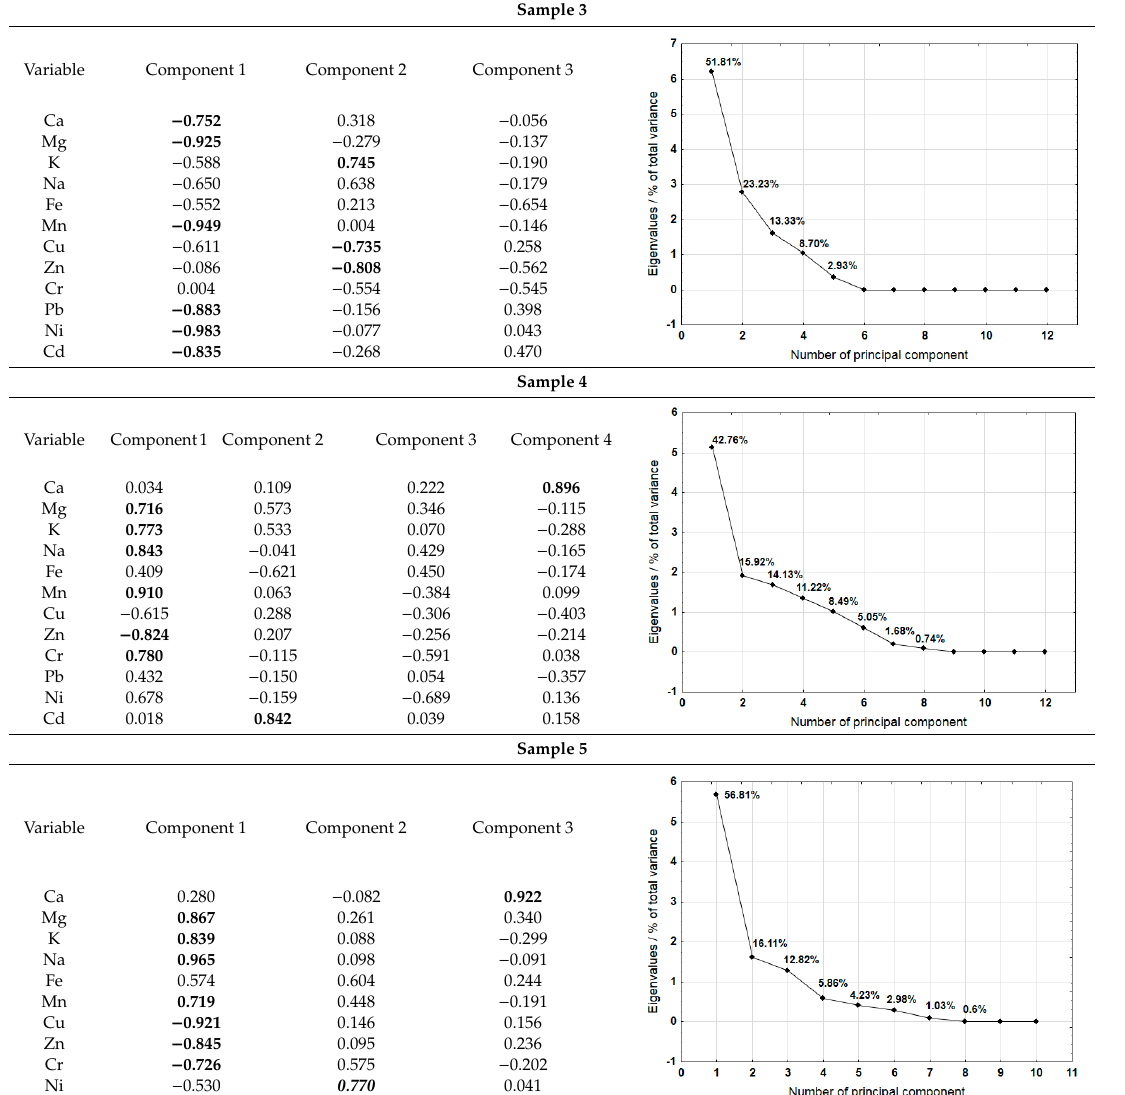
Table 7. The results of the Principal Component Analysis (PCA) for samples 3, 4, and 5. Sample 3 Component Variable 1